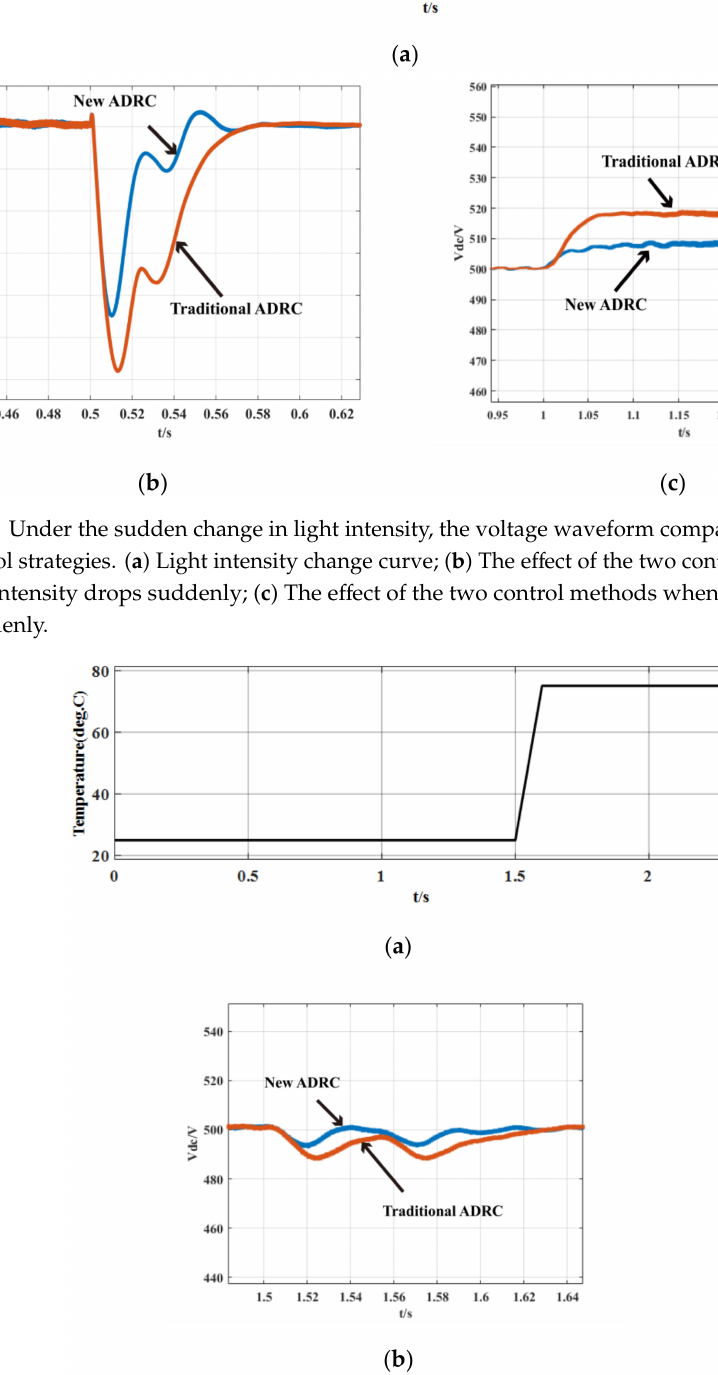
Figure 15. Comparison of DC bus voltage waveform simulation with two control strategies under abrupt temperature conditions. ( a ) Temperature abrupt curve; ( b ) Comparison of control e ff ects of two control strategies under abrupt temperature